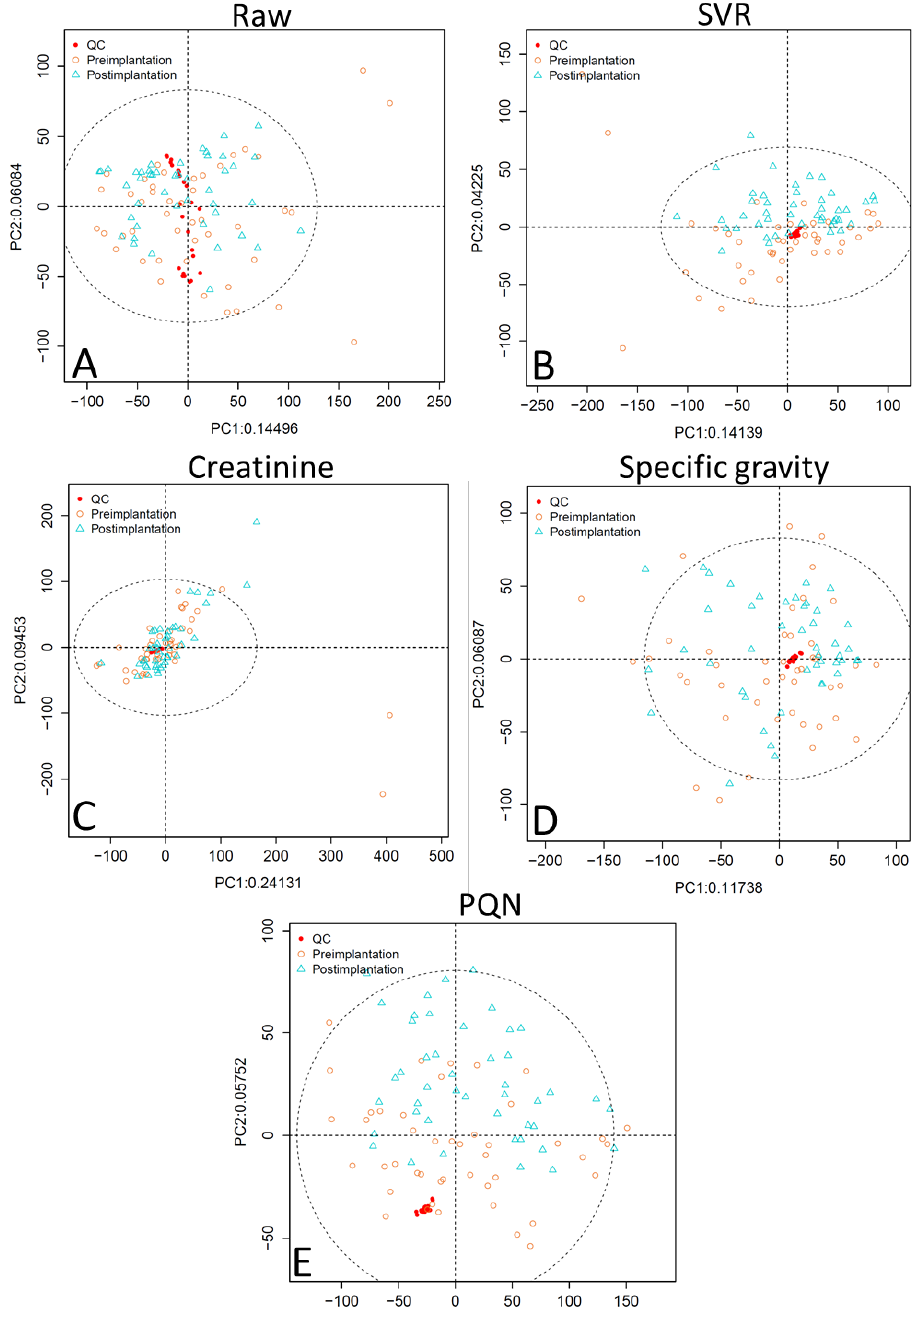
Figure 2. Unsupervised PCA plots comparing normalization approaches for HILIC data showing ( A ) raw data, ( B ) SVR-normalized data, ( C ) SVR and creatinine-normalized data, ( D ) SVR and specific gravity-normalized data, and ( E ) SVR and PQN-normalized data. Abbreviations: HILIC, hydrophilic interaction chromatography; SVR, support vector regression; PQN, probabilistic quotient normalization; PC1, principal component 1; PC2, principal component 2; ellipse is a 95% confidence ellipse.